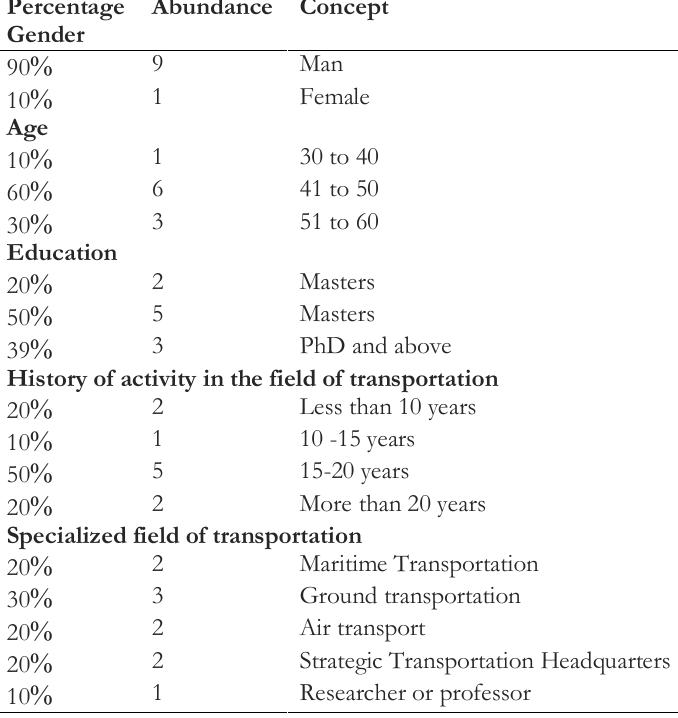
Table A. Demographic characteristics of